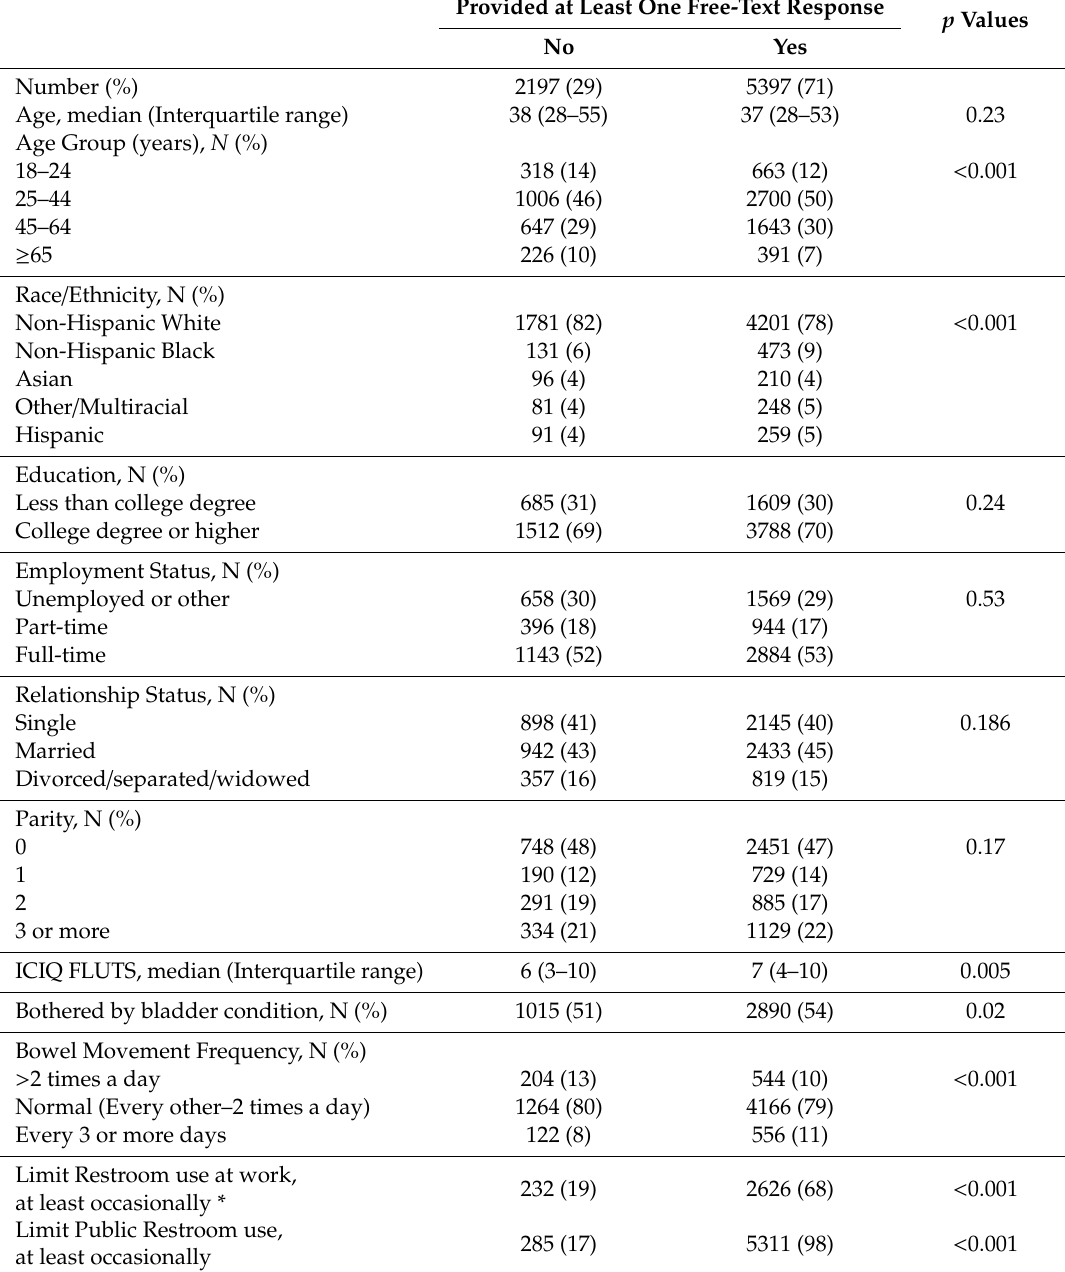
Table 1. Demographic and clinical information of women entering free-text responses that informed the qualitative analysis, compared to those who did not enter any